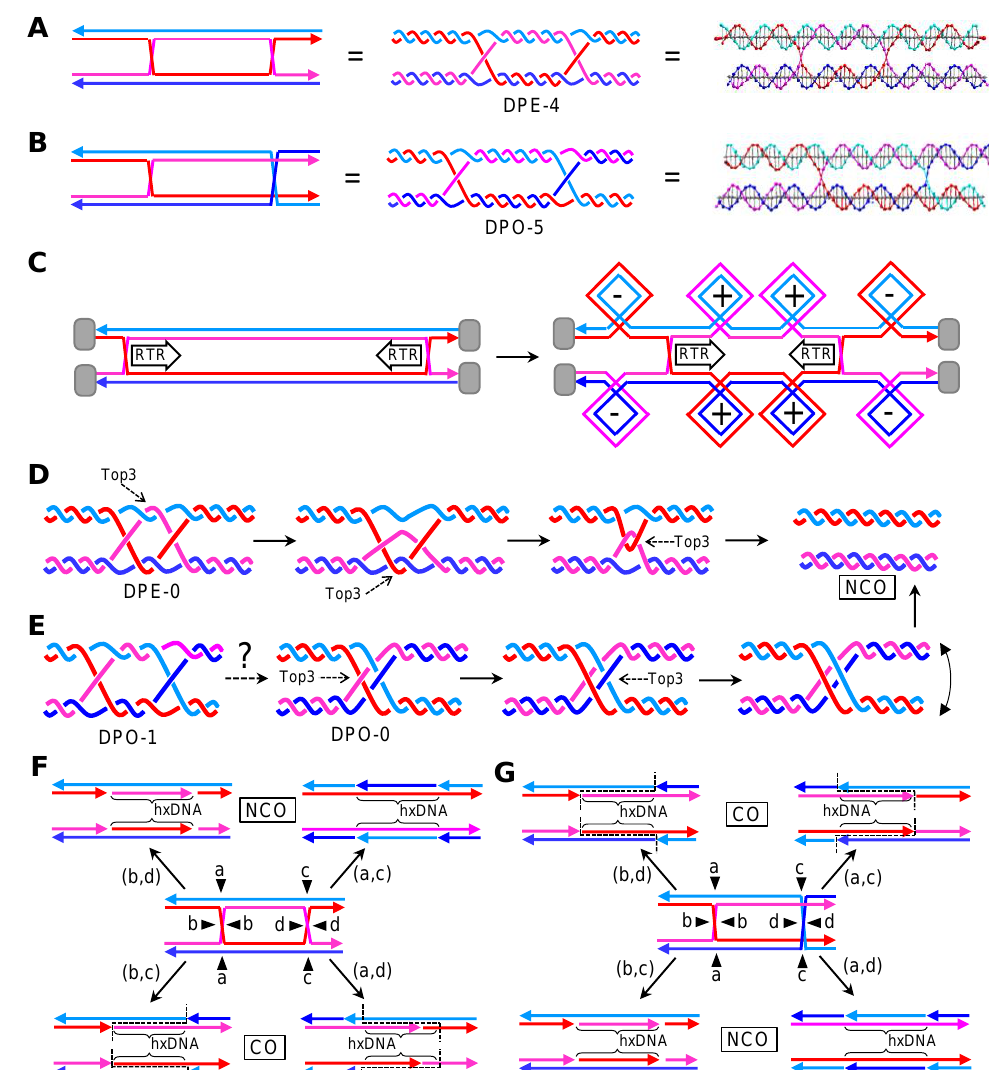
Figure 4. Features of the double canonical Holliday junction (dcHJ). ( A ) Classical 2D schematics of the dcHJ depicted in DSBR models. The double cross-joins involve the same two strands (Watson strands in this example). This kind of dcHJ spans an even number of half helical turns. The schematics depict the parallel conformation with 4 helical half turns between the cHJs (DPE-4; D stands for dHJ, P for parallel conformation and E for even number of helical half turns). ( B ) 2D schematics of an dcHJ isomer where each cHJ has a di ff erent cross-join partner (Watson strands in the first cHJ and Crick stands in the second cHJ). This isomer changes the number of helical half-turns to an odd number; in this example, there are 5 half-turns (DPO-5; O stands for odd). ( C ) Converging branch migration of dcHJs results in twice more positive ( + ) and negative ( − ) supercoiling than migrating a single cHJ the same distance. ( D ) Converging Branch migration of a DPE dcHJ to zero half-turns gives rise to hemicatenanes that tie the four strands as in a sailing knot. The complexity of the knot depends on the cross-join topology (Figure 2D). Top3 can unlink the strands as in the example so that the dcHJ is dissolved. ( E ) Converging Branch migration of a DPO dcHJ to zero would give rise to a topologically distinct sailor knot. To reach a DPO-0, branch migration should take place in steps of half-turns or less, so that the DPO-1 to DPO-0 transition is feasible. ( F ) The resolution of the DPE dcHJ and its genetic outcomes. Depending on the cutting planes, the resolution can end up in products with or without a terminal genetic exchange—i.e., crossover (CO) or non-crossover (NCO), respectively. Regardless of the product, resolution results in hxDNA between the cHJs (regions with brackets, and also dash lines in COs). ( G ) The resolution and genetic outcomes of the DPO dcHJ are similar than the DPE dcHJ, albeit with swapped NCO / CO products for the indicated cutting planes. For other details see previous figure legends.